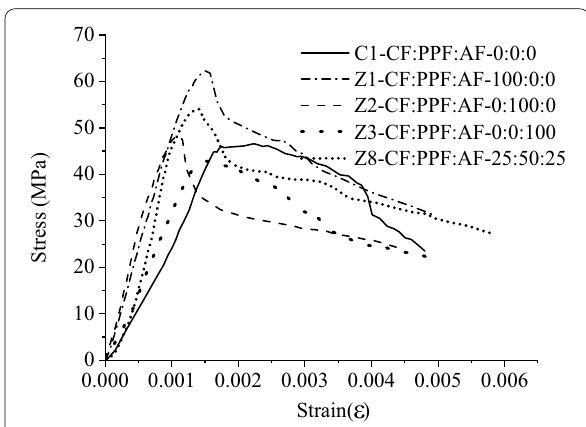
Fig.9 Axial stress–strain relationship. The test datum of each point is derived from the average of three replicates.